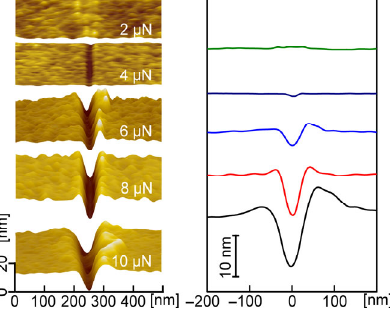
Fig. 2 Typical AFM surface topographical images and average cross-section profiles of the material removal traces after performing wear tests on the polished pure iron surface against a diamond tip in vacuum.